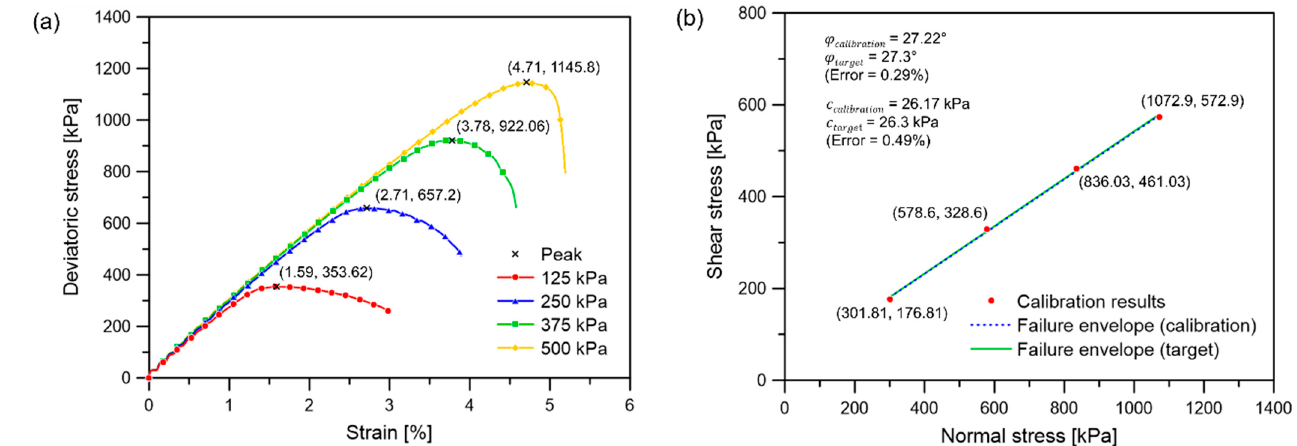
Figure 5. Results of large-scale triaxial tests for calibration of contact parameters: ( a ) stress–strain curve; ( b ) Mohr–Coulomb failure envelope. Table 4. Calibrated parameters after large-scale triaxial